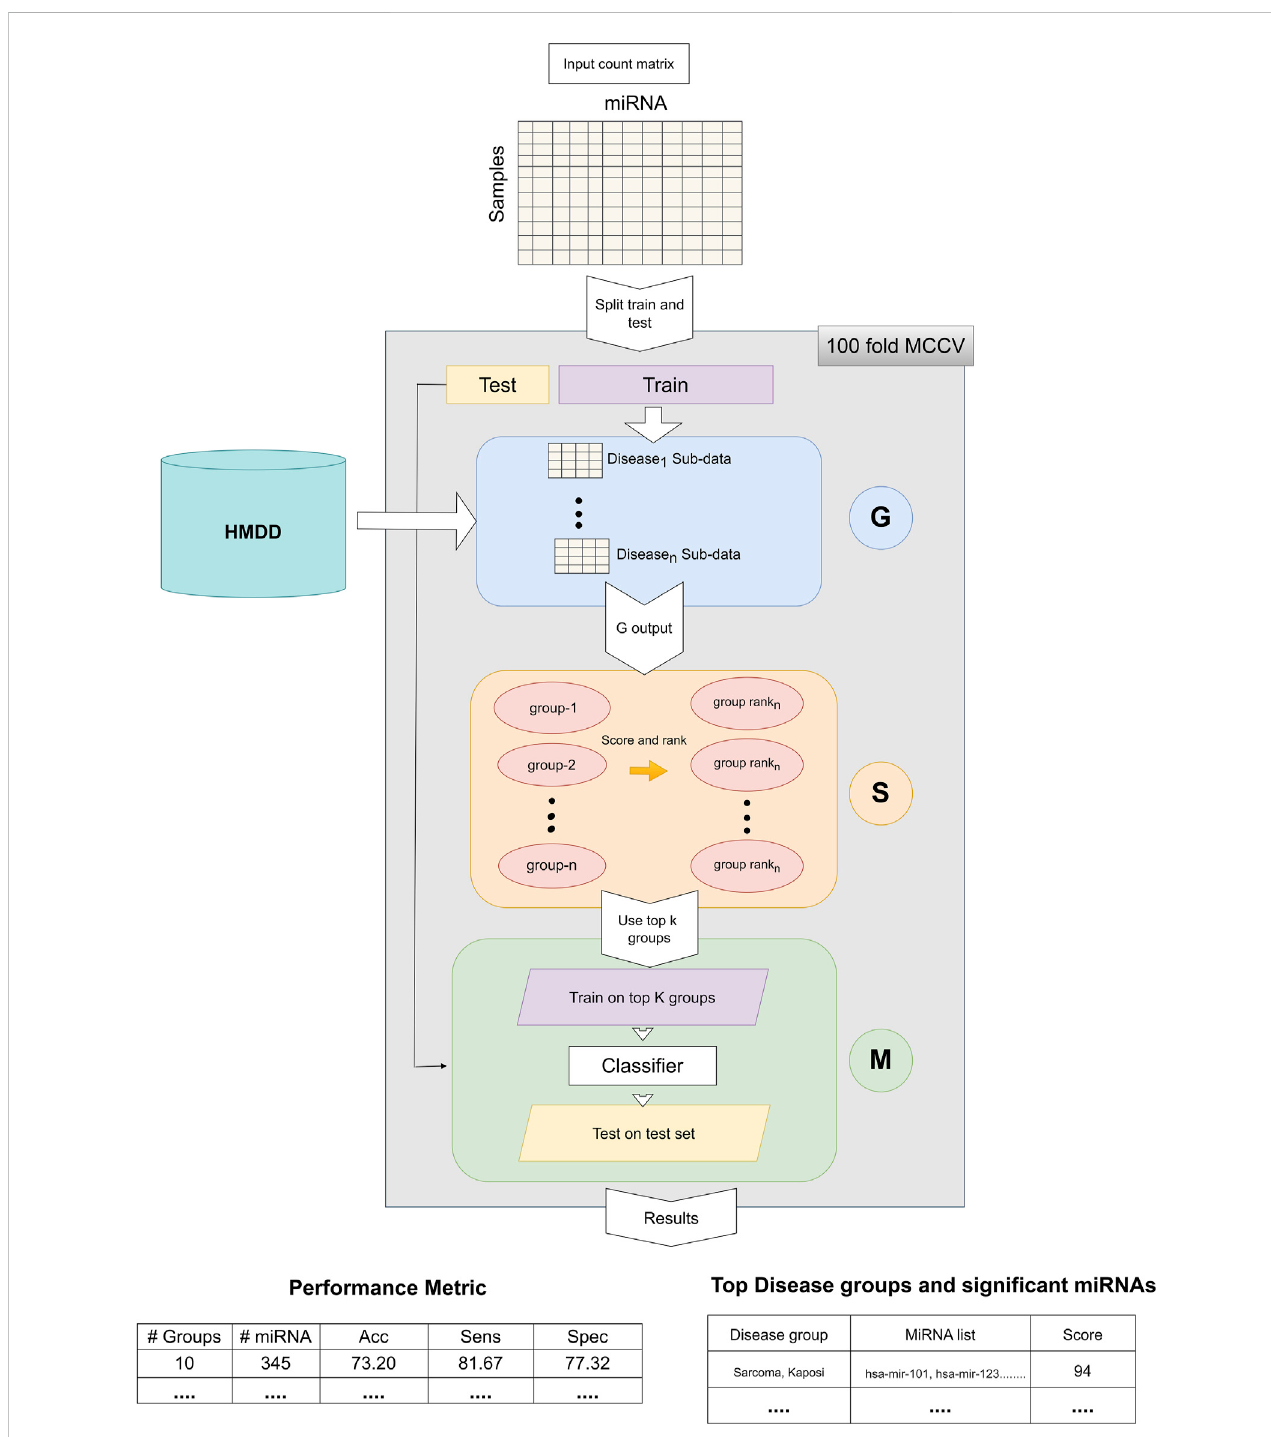
FIGURE 1 The general approach of miRdisNET. It consists of three components: G component generates sub-datasets for each speci fi c disease group; S component performs scoring and then ranking of the speci fi c disease groups; M component creates the classi fi er, trains and evaluates the performance of